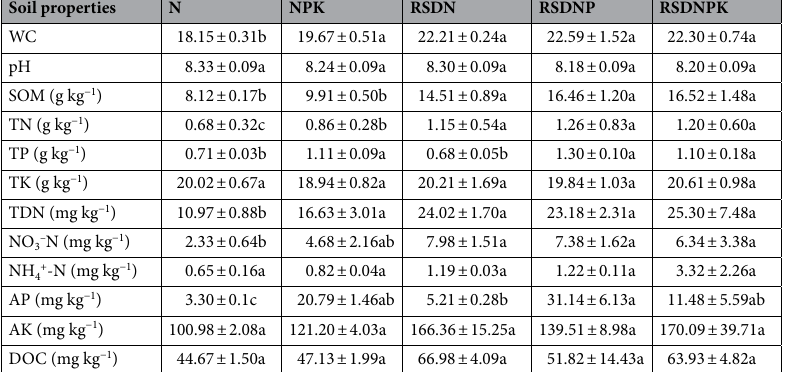
Table 1. Soil properties under different fertilizer regimes. SOM soil organic matter, TN total nitrogen, TP total phosphorus, TK total potassium, AP available phosphorus, AK available potassium, TDN dissolved total nitrogen, DOC dissolved organic carbon, NH 4+ -N ammonium nitrogen, NO 3– N nitrate nitrogen, WC water content, N synthetic N fertilizer, NPK synthetic fertilizer: nitrogen, phosphorus and potassium, RSDN crop residues returned with nitrogen, RSDNP crop residues returned with nitrogen and phosphorus, RSDNPK crop residues returned with nitrogen, phosphorus and potassium. Within a row, values (mean ± standard error) with different letters (a, b and c) indicate significant differences (one-way ANOVA with LSD test, P < 0.05; n = 3) among the fertilization